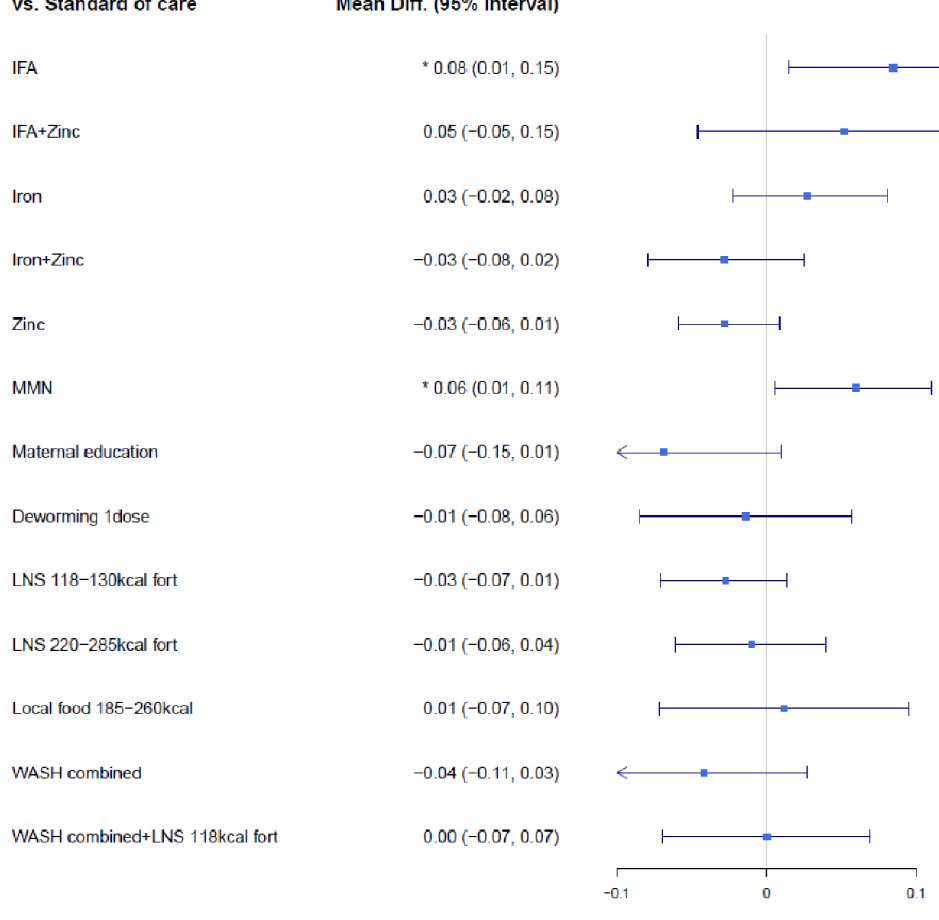
Figure 3. Forest plot for the effects of interventions on HAZ (mean difference), primary analysis. Vit. vitamin; IFA, iron and folic acid; LNS, lipid-based nutrient supplements; Fort, fortification; MMN, multiple micronutrients; WASH, – water treatment, toilet facilities, and handwashing. * Denotes mean difference values that do not contain the null effect of